Question: Give a one-sentence summary of this figure.
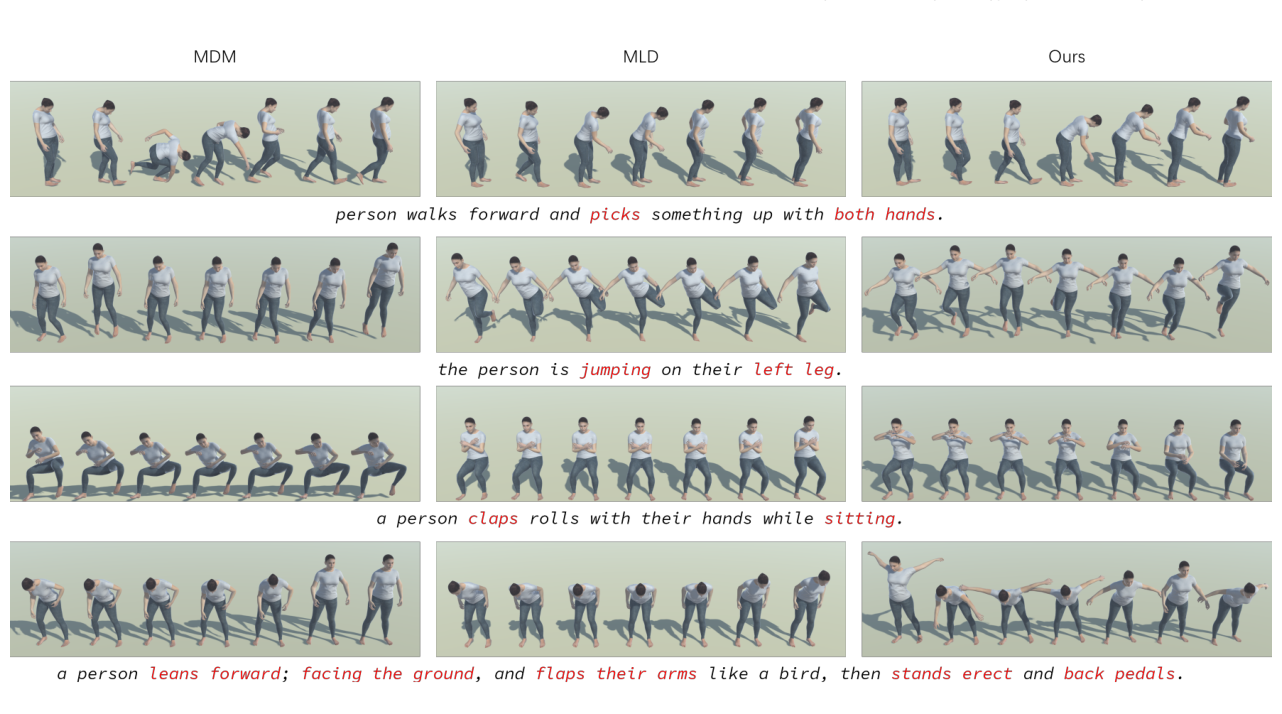
Answer: Qualitative comparison of results generated by our method with those from MDM [Tevet et al. 2022b] and MLD [Chen et al. 2023b].